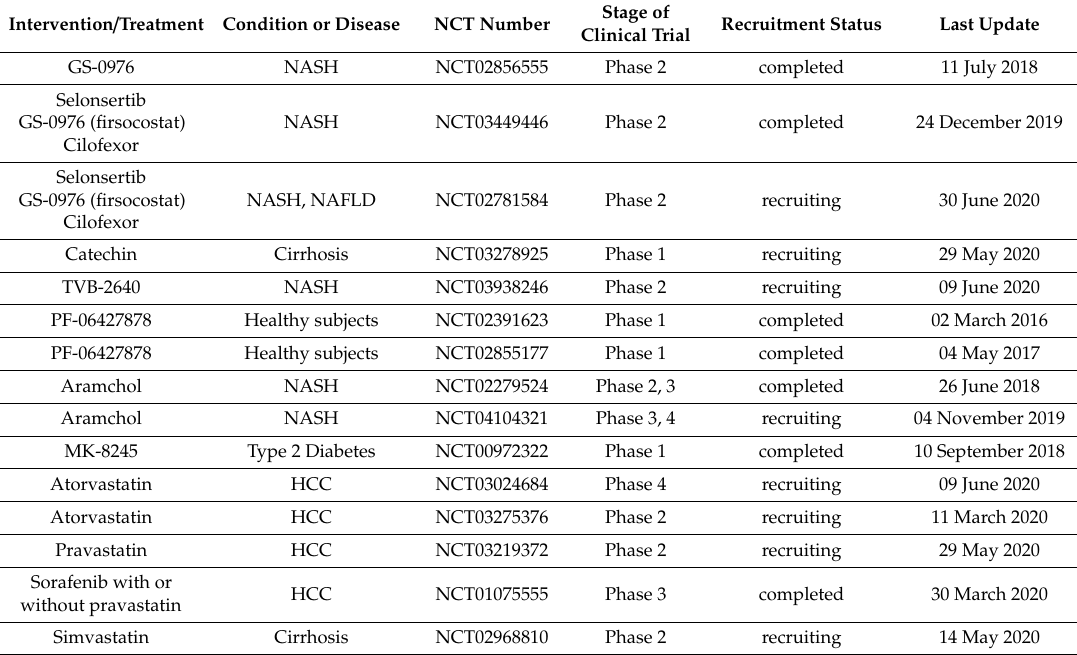
Table 1. Overview of several clinical trials targeting lipid-metabolism-associated factors in liver diseases. Intervention / Treatment Condition or